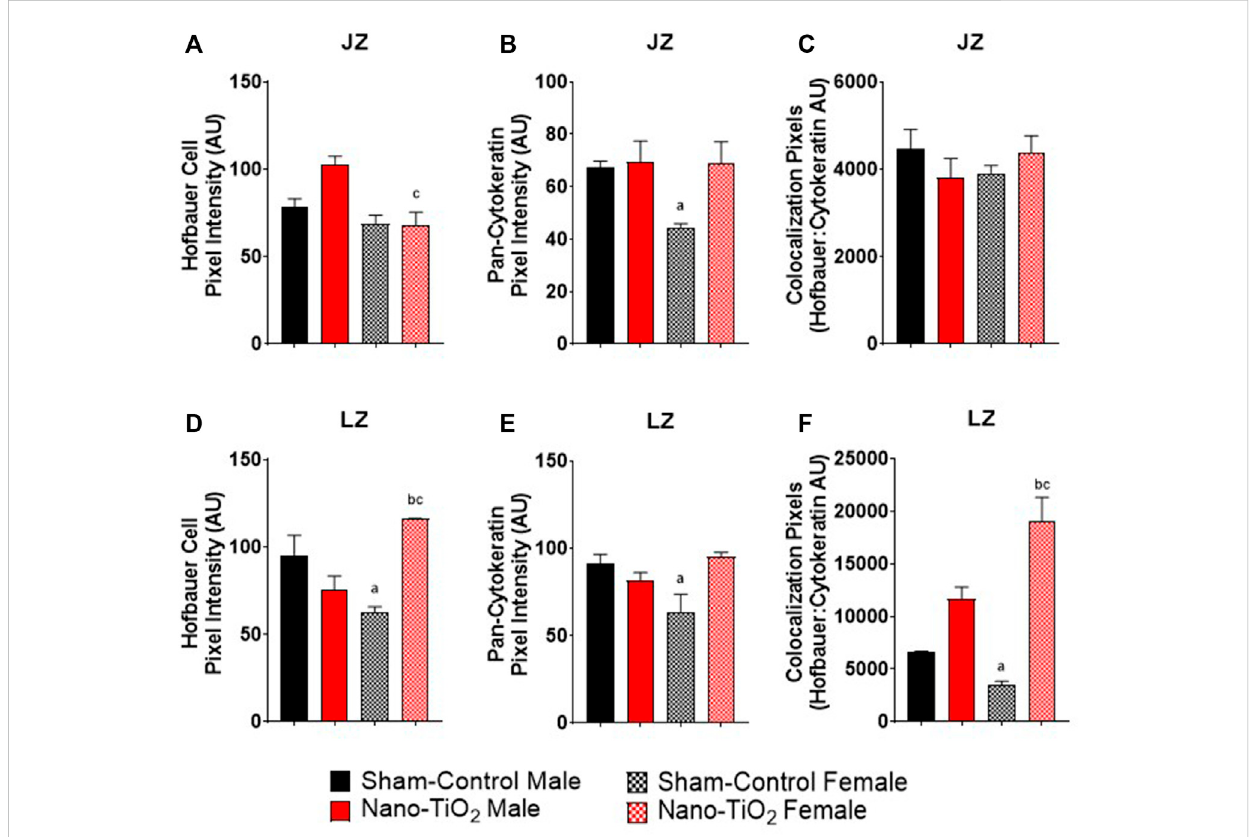
FIGURE 9 PlacentalZoneImmunohistochemistry.Placental fl uorescenceintensityandcolocalizationofanti-CD163andanti-pancytokeratinineachplacenta zone. (A) Junctionalzone(JZ)pixelintensityofanti-CD163(Hofbauercell). (B) JZpixelintensityforpan-cytokeratin. (C) JZcolocalizationforCD163:pan- cytokeratin. (D) Labyrinth zone (LZ) pixel intensity for Hofbauer cells. (E) LZ pixel intensity for pan-cytokeratin. (F) LZ colocalization for CD163: pan- cytokeratin. Sham-controlmales (n=5),sham-control females(n=5),nano-TiO 2 males (n=5),and nano-TiO 2 females(n=5).a, p ≤